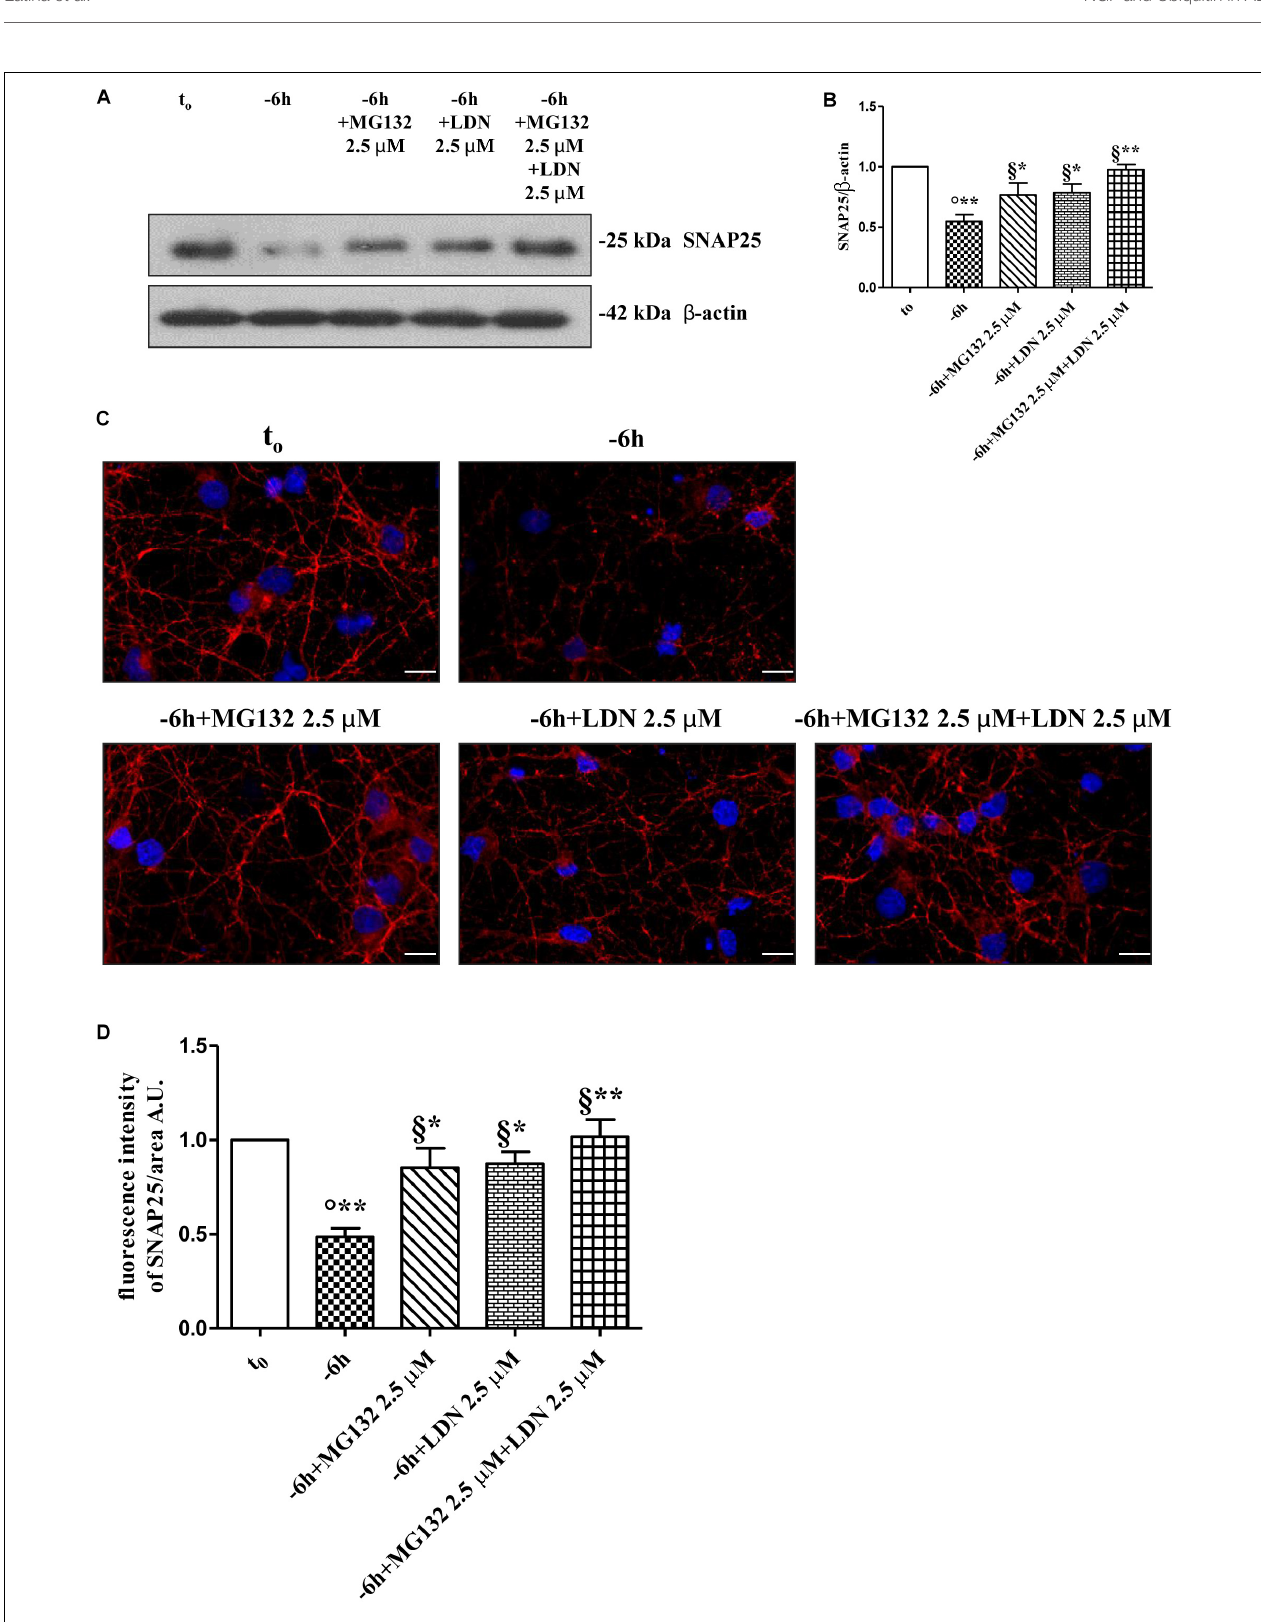
FIGURE 5 | Co-treatment with MG132 and LDN has additive effect in preventing the presynaptic degeneration occurring in –6 h NGF-deprived cholinergic neurons. (A–D) Septal cholinergic-enriched cultures were grown continuously (10–12 D.I.V.) in 0.2% B27 media in the presence of exogenous NGF (100 ng/ml) from